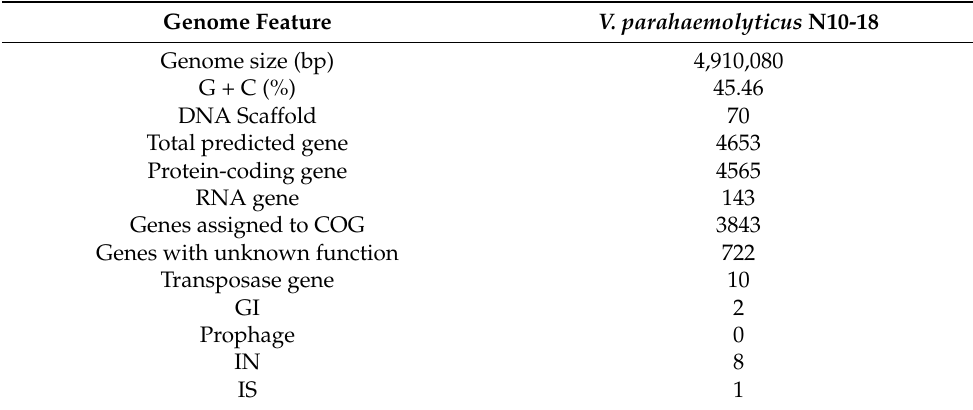
Table 1. General features of the V. parahaemolyticus N10-18 genome. Genome